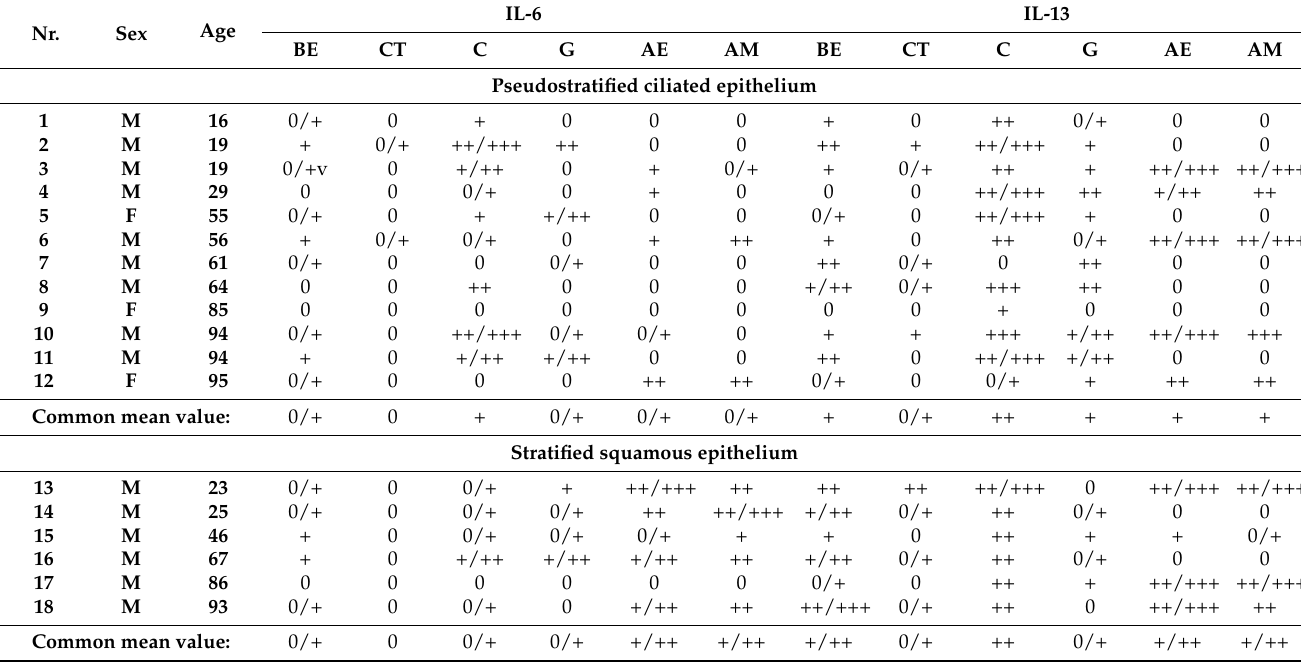
Table 2. Relative number of IL-6 and IL-13 positive structures in the pseudostratified ciliated epithelium and squamous stratified epithelium.